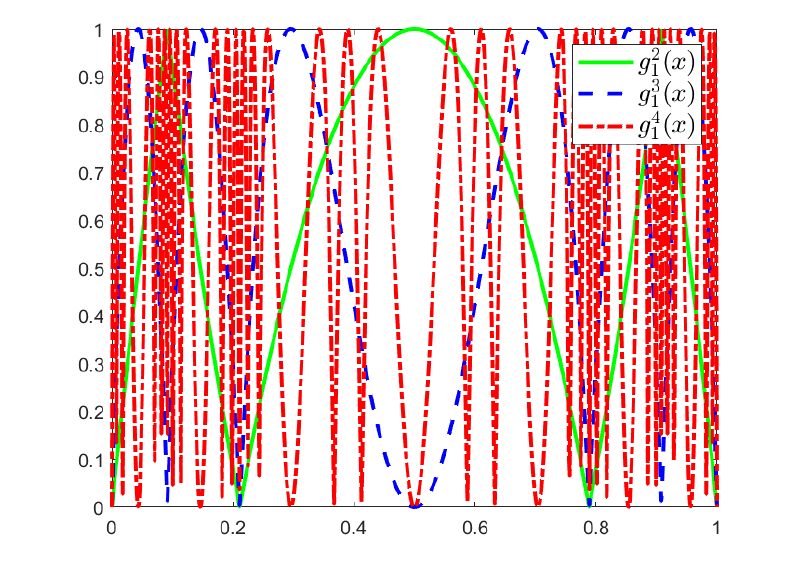
Figure 3. The function images of g 2